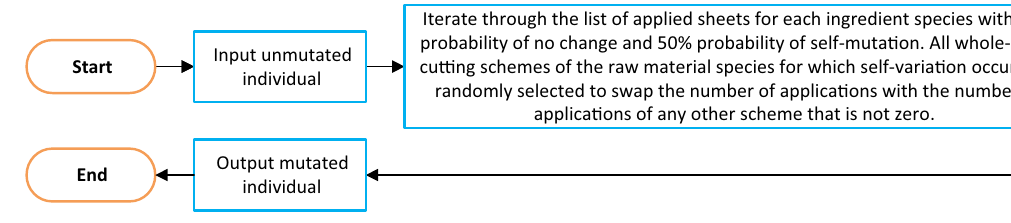
Figure 22. Flowchart of mutation function of genetic algorithm.